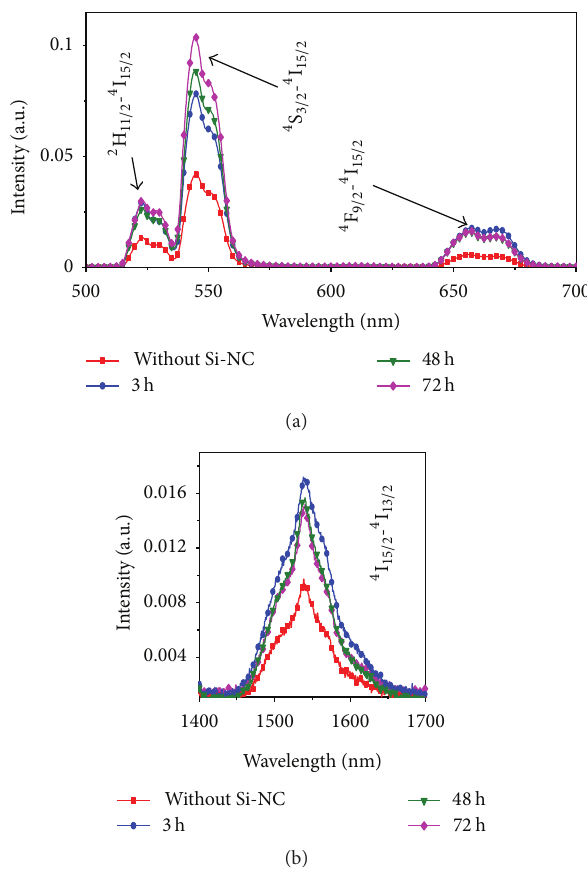
Figure 20: Emission spectra of the Er 3+ doped GeO 2 -Bi 2 O 3 glass withSiNPsheat-treatedduringdifferenttimeintervals.(a)Infrared- to-visible frequency upconversion. (b) Frequency downconversion [5].